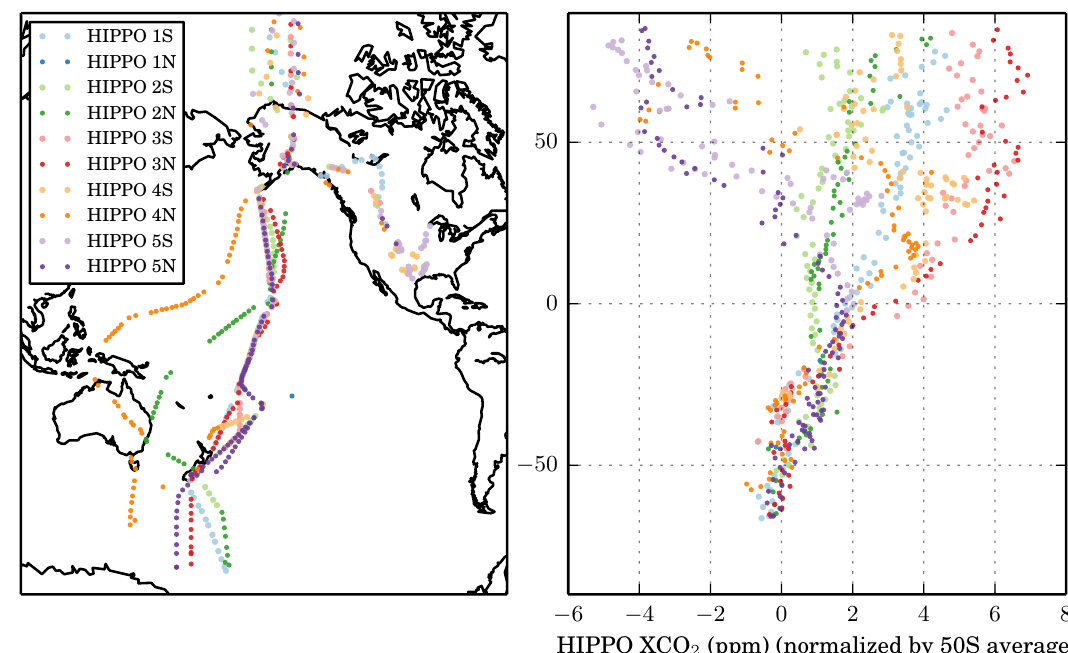
Figure 1. Left: Overview of the 5 HIPPO campaigns, taken place in January 2009 (1), November 2009 (2), March/April 2010 (3), June/July 2011 (4) and August/September 2011 (5). Campaigns are separated by Southbound (S) and Northbound (N) and each dot in- dicates a separate HIPPO vertical profile. Right: Latitudinal gradients of column-averaged CO 2 mixing ratios with the campaign average at 50S subtracted. Above the highest HIPPO flight altitude, profiles have been extended with CarbonTracker CT2013B in order to compute the column